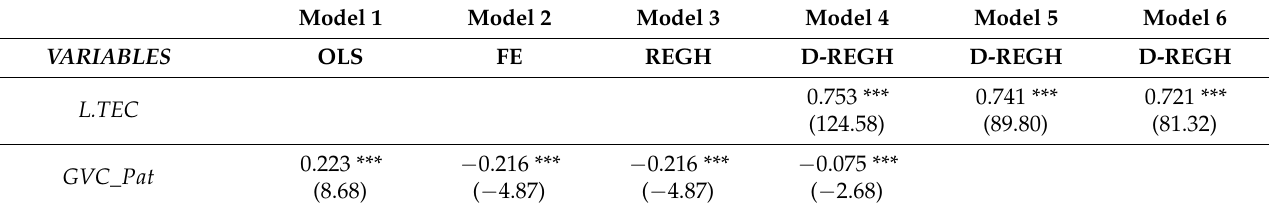
Table 2. Baseline regression